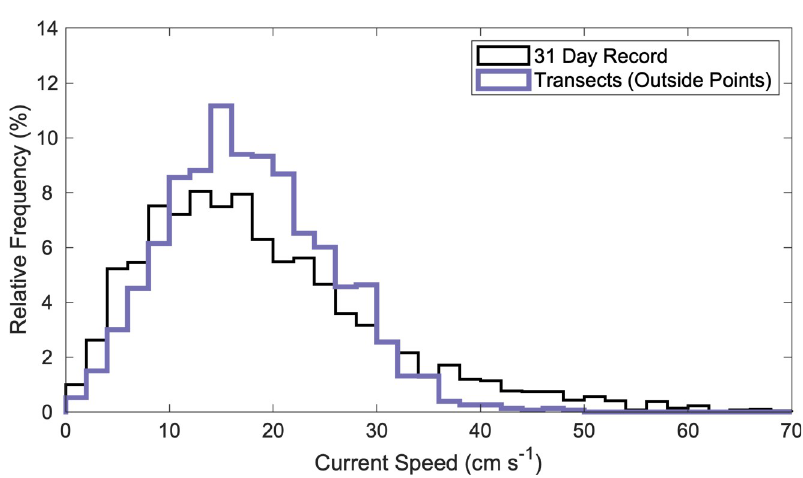
Fig 7. Current speeds on the Windmill Point summer sampling cruise compared to the one-month record. Transect measurements from outside the farm footprint (thick purple line) compared to the measurements collected by the ADP (thin black